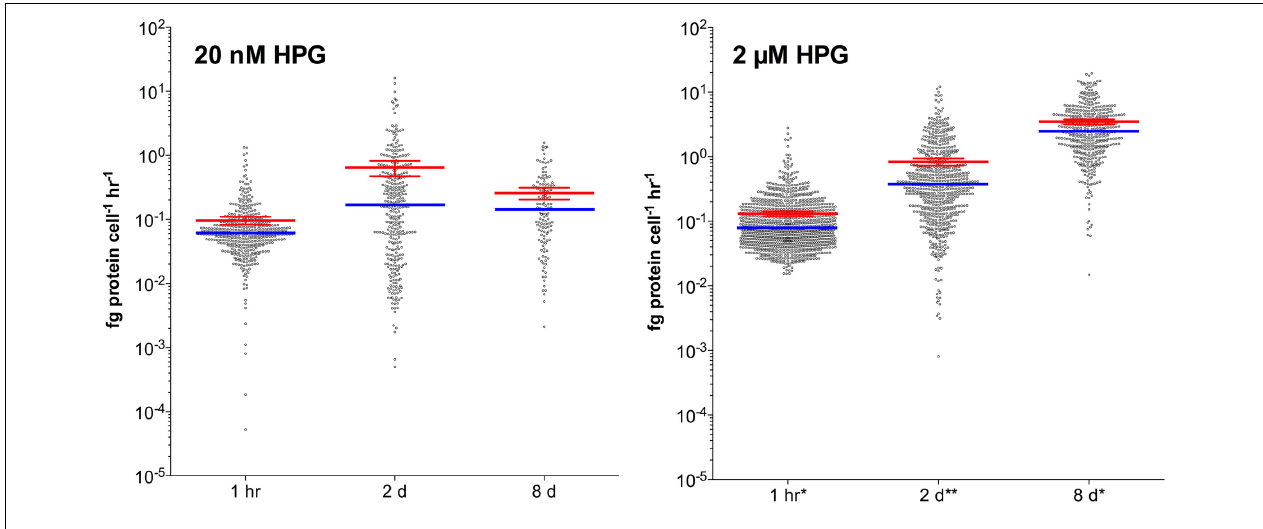
FIGURE 5 | HPG-based protein synthesis rates for particle-attached bacteria incubated with 20nM or 2 µ M HPG. Incubations were sampled at 1h, 2 day, and 8 day. Red bars show means ( ± 95%